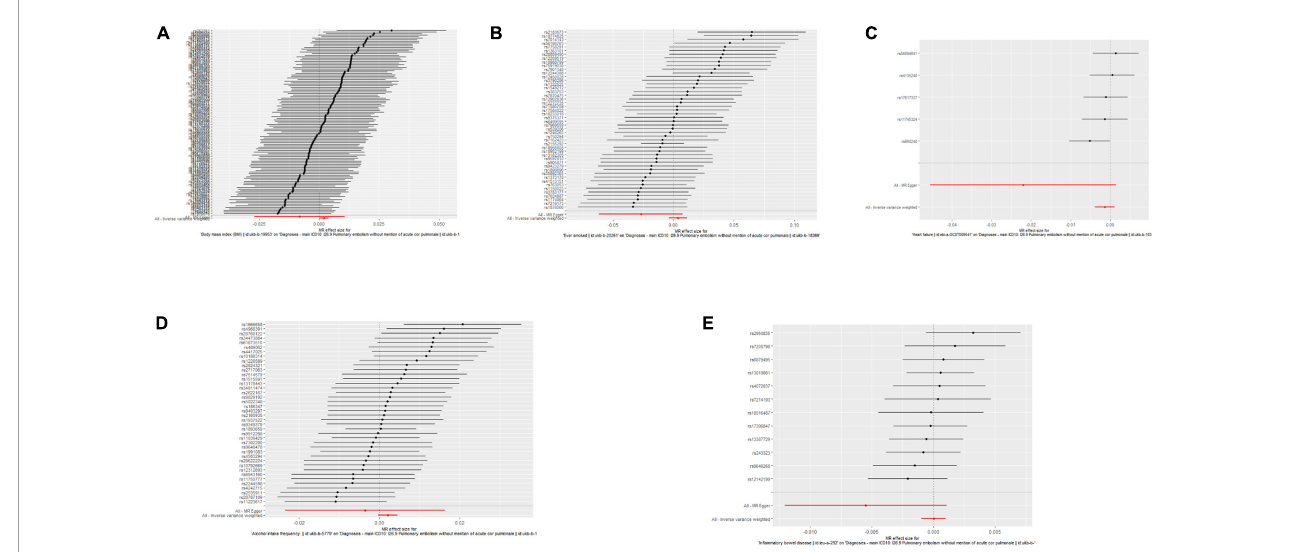
FIGURE3 Forest plots of the causal effects of body mass index (BMI), ever-smoking, heart failure, alcohol intake frequency, and inflammatory bowel disease (IBD)-related single nucleotide polymorphism (SNPs) on pulmonary embolism (PE). The Mendelian randomization (MR) estimated effect sizes for BMI (A) , ever smoking (B) , heart failure (C) , frequency of alcohol intake (D) , and IBD (E) are shown. Data are expressed as beta values and 95% CI.